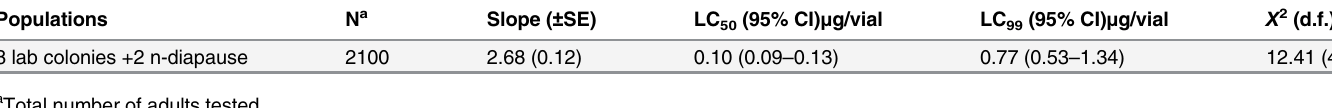
Table 1. Baseline susceptibility and diagnostic concentration (LC 99 ) ( ± 95% Confidence Interval) of western corn rootworm adults by contact to bifenthrin, combined for overall analysis, from laboratory colonies maintained over several generations.